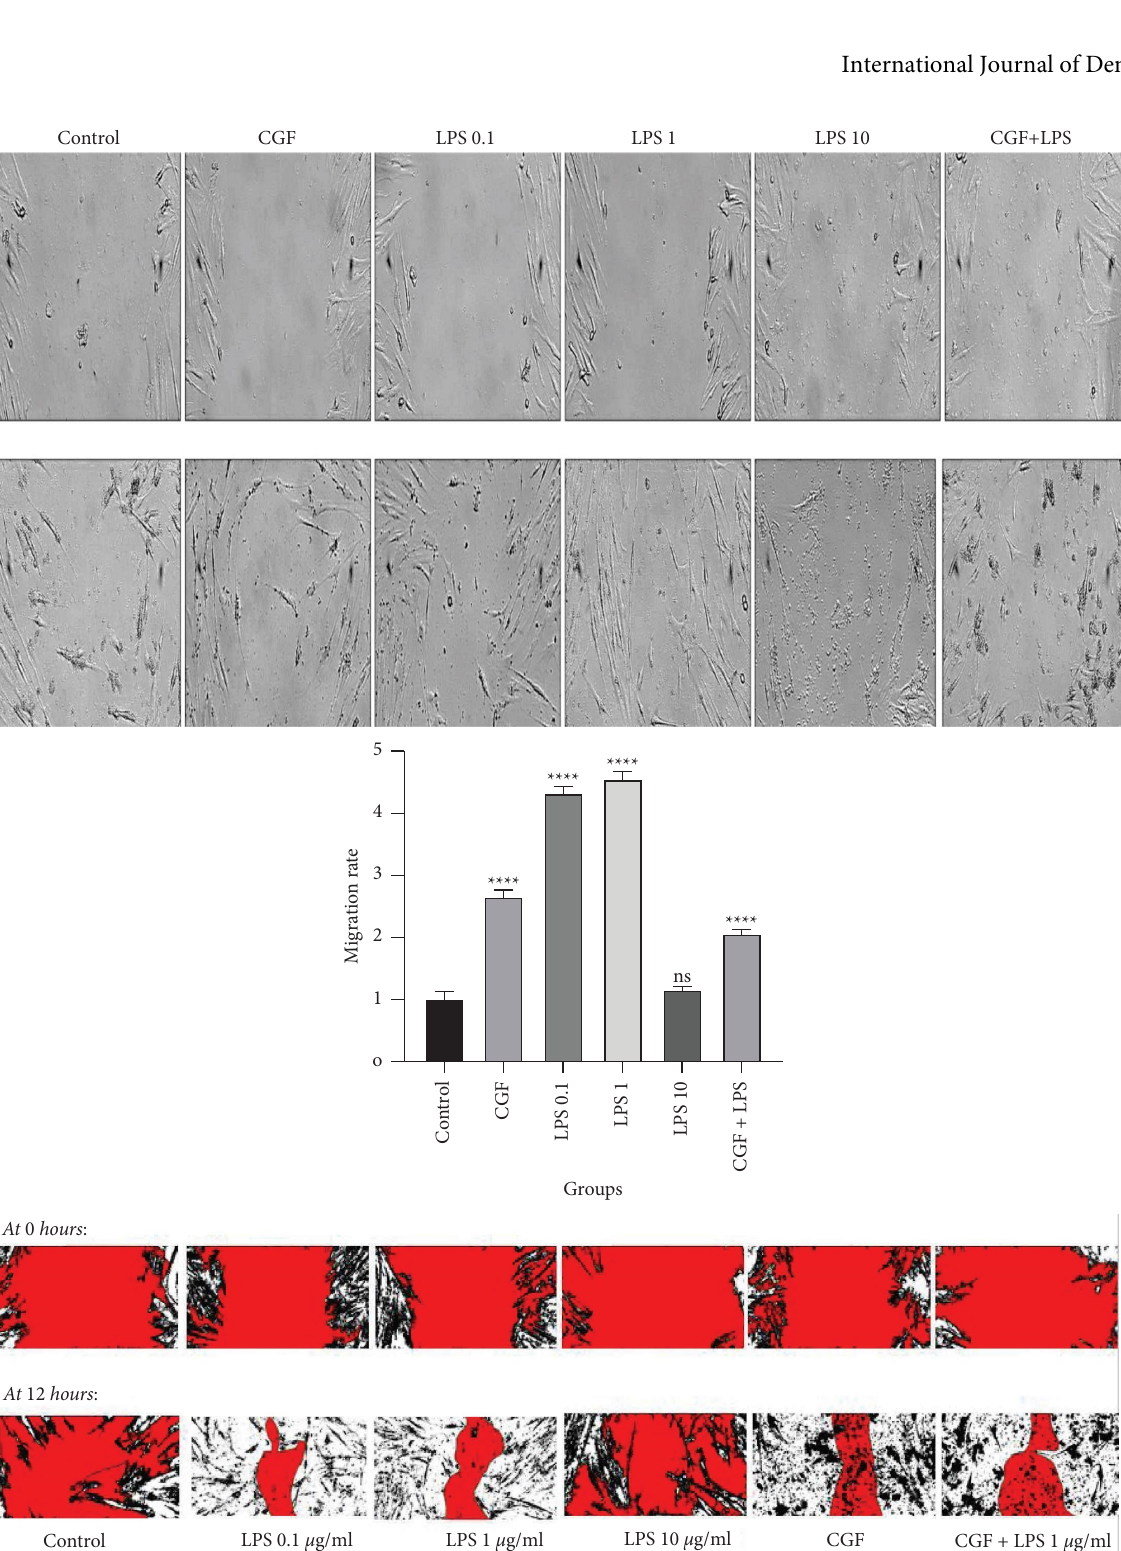
Figure 5: Te migration ability of dental pulp stem cells (DPSCs) following treatment according to the scratch assay. Te results show that concentrated growth factor (CGF), either alone or in the presence of lipopolysaccharide (LPS), could signifcantly increase DPSC migration; ∗∗∗∗ p < 0 . 0001 and ns �